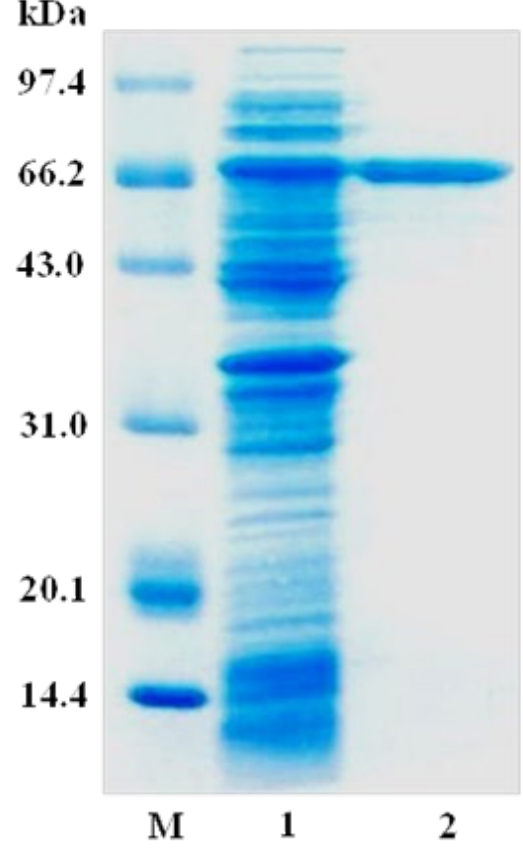
Figure 2. SDS-PAGE analysis of purified AlFFase3. Lane M—low molecular weight standard protein Figure 2. SDS- PAGE analysis of purified AlFFase3. Lane M—low molecular weight standard pro- markers; lane 1—crude lysate; lane 2—purified tein markers; lane 1—crude lysate; lane 2— purified AlFFase3.